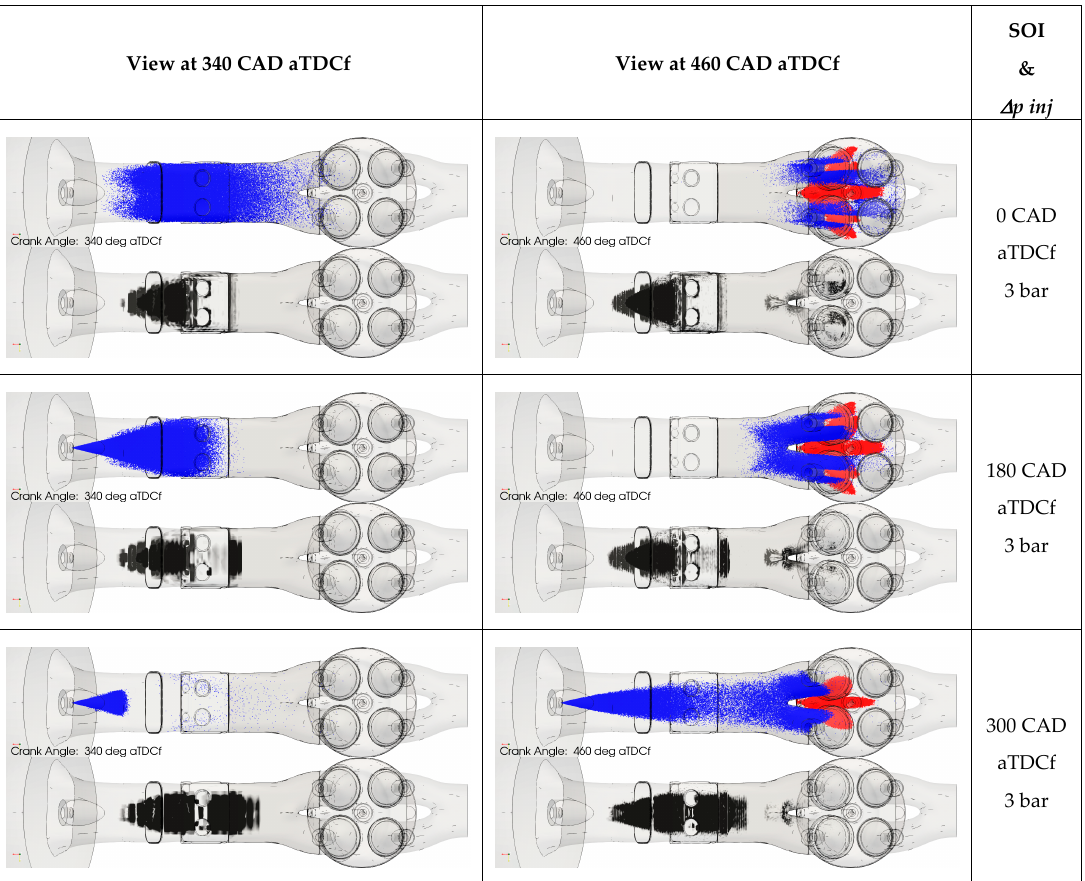
Figure 9. Liquid water balance in the ports and runner. Percentages refer to the injected water mass: ( a ) liquid water entering the cylinder; ( b ) wall film mass.